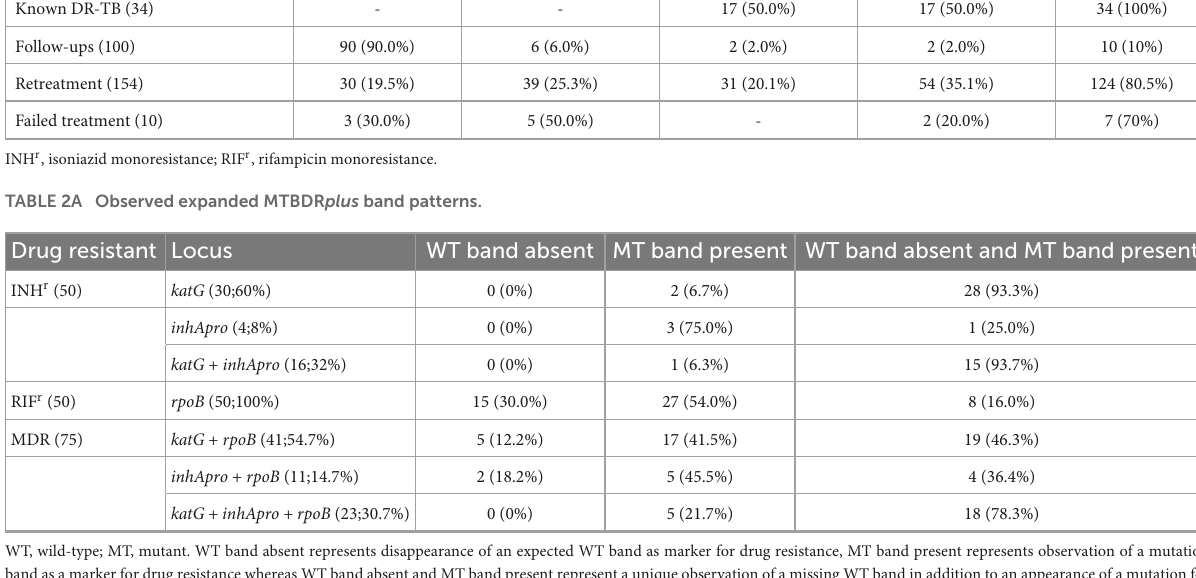
TABLE 1 Distribution of first line anti-TB drug resistance among 298 difficult-to-treat (DTT) tuberculosis (TB) cases. Patient category (Number of